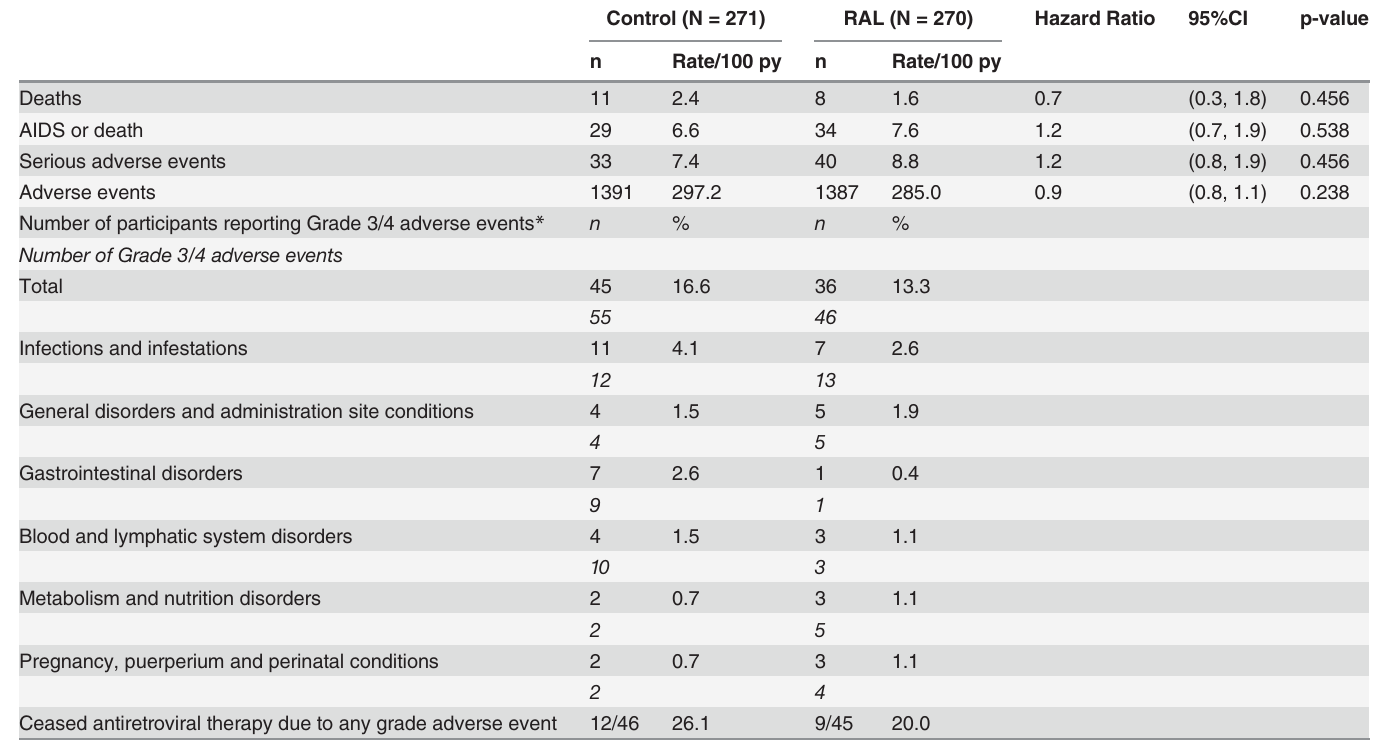
Table 2. Clinical outcomes by randomised